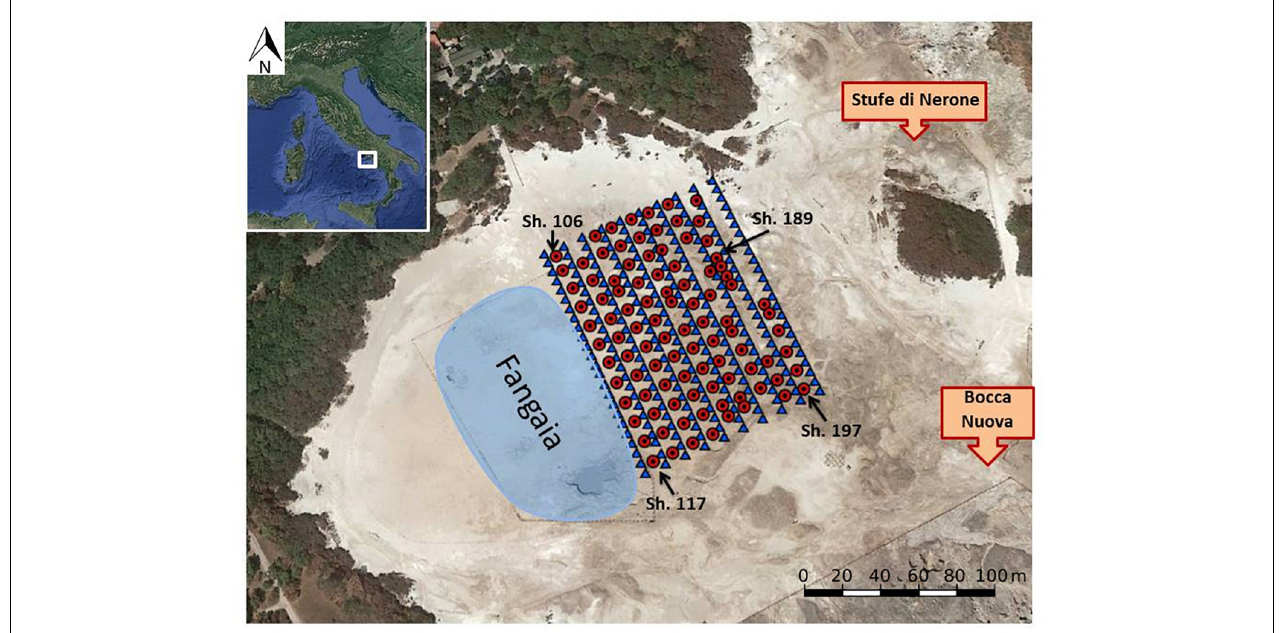
FIGURE 2 | RICEN experiment layout: the red dots represent the shots, the blue triangles the stations. The arrows indicate the shots analyzed in Figure 2 . The maps has been obtained with Google Maps 9.38.1 2019 (Map data: Google, DigitalGlobe): Solfatara, Pozzuoli, Metropolitan City of Naples, Italy retrieved from https://www.google.com/maps/@40.8174278,14.1393587,1292a,20y,41.32t/data= ! 3~m1 !